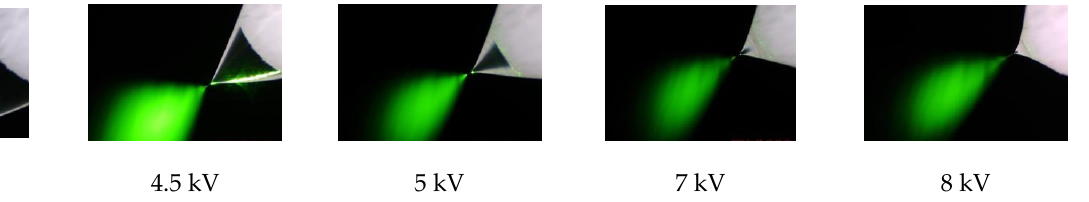
Figure 5. The photos of round marker tips in the range of potential 4–8 kV. Single Taylor cone for- mation.